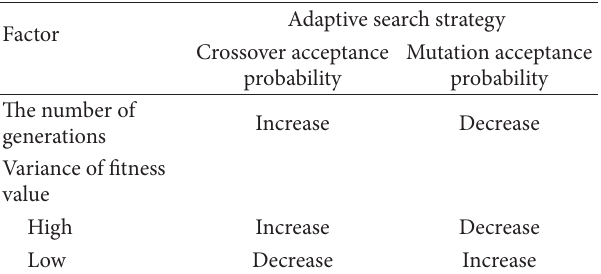
Table 1: Adaptive search